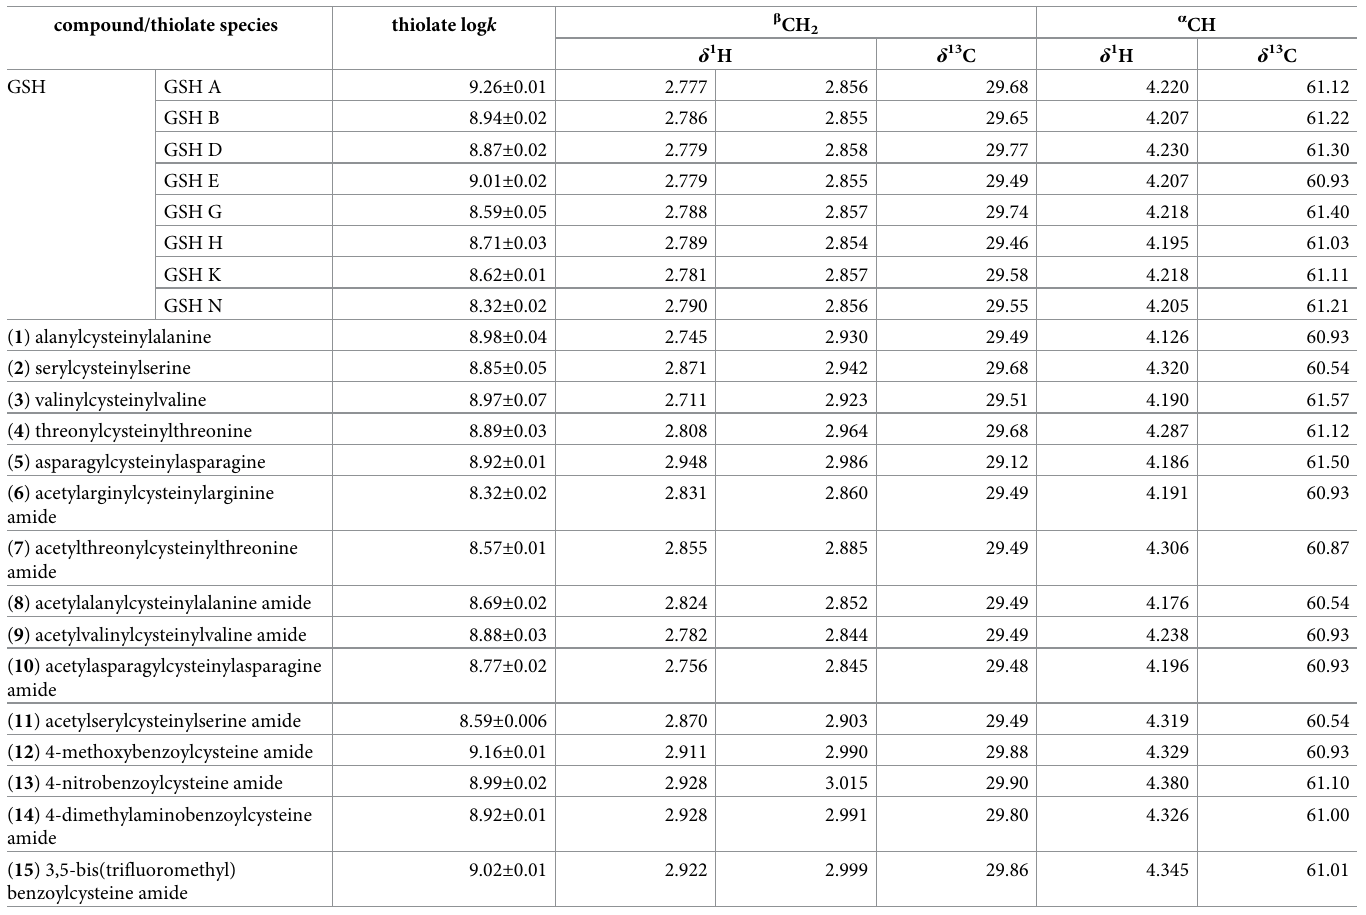
Table 3. The species-specific chemical shifts determined for the additional compounds studied (beyond cysteine and cystine) bearing thiolate moiety. The uncer- tainty of determination for chemical shift on the ppm scale is 0.001 and 0.01 for 1 H and 13 C chemical shift values, respectively. The thiolate protonation constants of gluta- thione were determined previously in [14], while the protonation constants of the peptides were determined as described in the Materials and Methods section and are reported in logk ± standard deviation of the regression fit. compound/thiolate species thiolate log